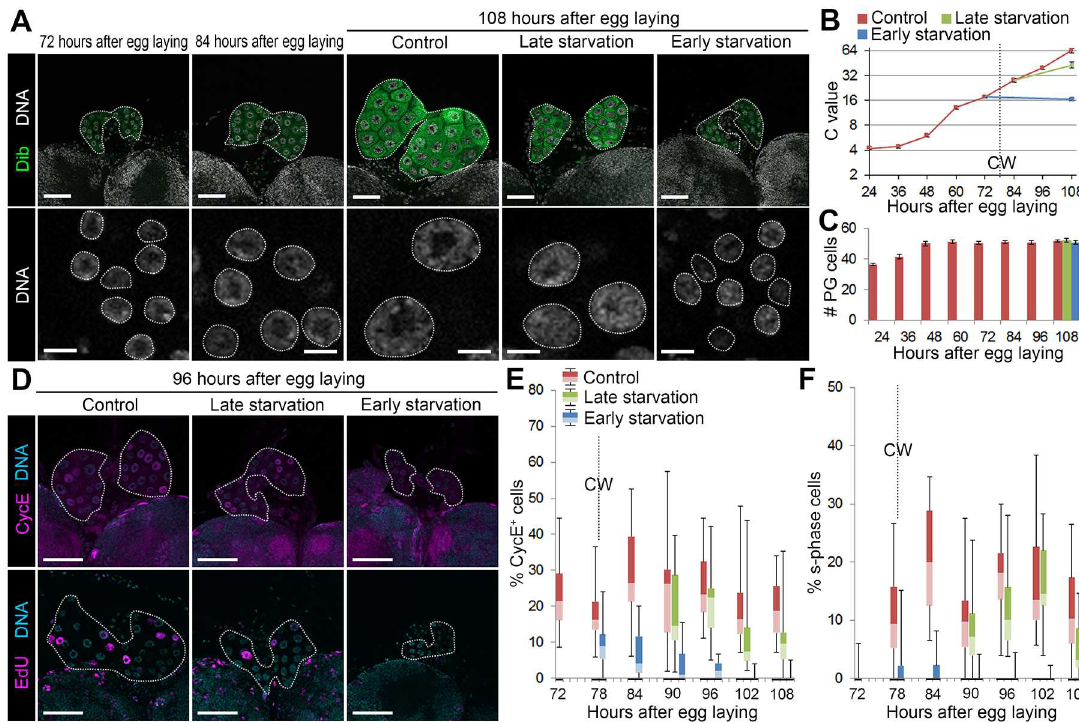
Fig 2. CW attainment is correlated with endocycle activity in the PG. (A) Starvation before CW attainment causes arrest of DNA content increasein the PG. The PGs (upper panels, outlined) and nuclei of PG cells (lowerpanels, outlined)were labeled for Dib (green) and DNA (white) at indicatedstages of the continuous feedingscheme. Scale bars, 50 μ m (upper panels) and 10 μ m (lower panels). (B and C) The C value (B) and number (C) of PG cells of control, late starved and early starved larvaeat indicatedstages. The CW checkpointin control is indicatedby a dashedline in B. Average C value in control at 108 hAEL is normalized to 64C. Error bars represent standard errors. 10–17PGs were analyzedfor each group. (D) Starvation before CW attainment causes decrease in CycE expressionand EdU incorporation in the PG. The PGs were labeledfor DNA (blue) and CycE or EdU (magenta) at 96 hAEL. The PGs are outlinedby dashedlines. Scale bars, 50 μ m. (E and F) Percentages of CycE- positive (E) and EdU-positive (F) s-phasePG cells in control, late starved and early starved larvae at indicatedstages. All data are shown as box plot, with a box representing lower and upper quartiles, a horizontalline representingmedian,and bars representing minimum and maximum data points. The CW checkpointin control is indicatedby dashed lines. 19–30 PGs were analyzedfor each group.